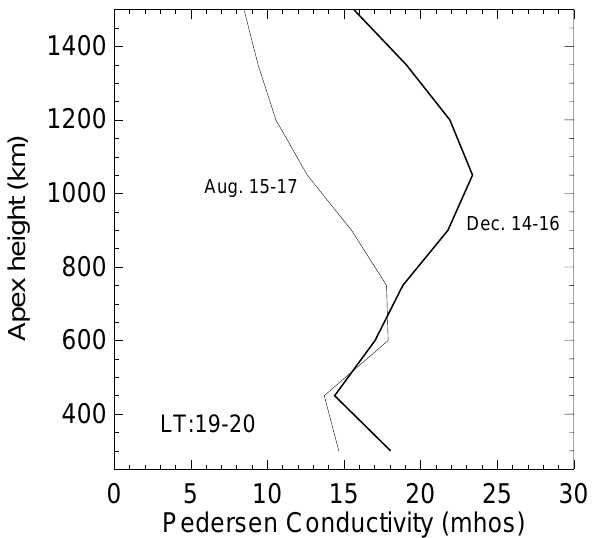
Fig. 3. 6 F at 19:00–20:00 LT in the Atlantic sector during 15– P 17 August and 14–16 December